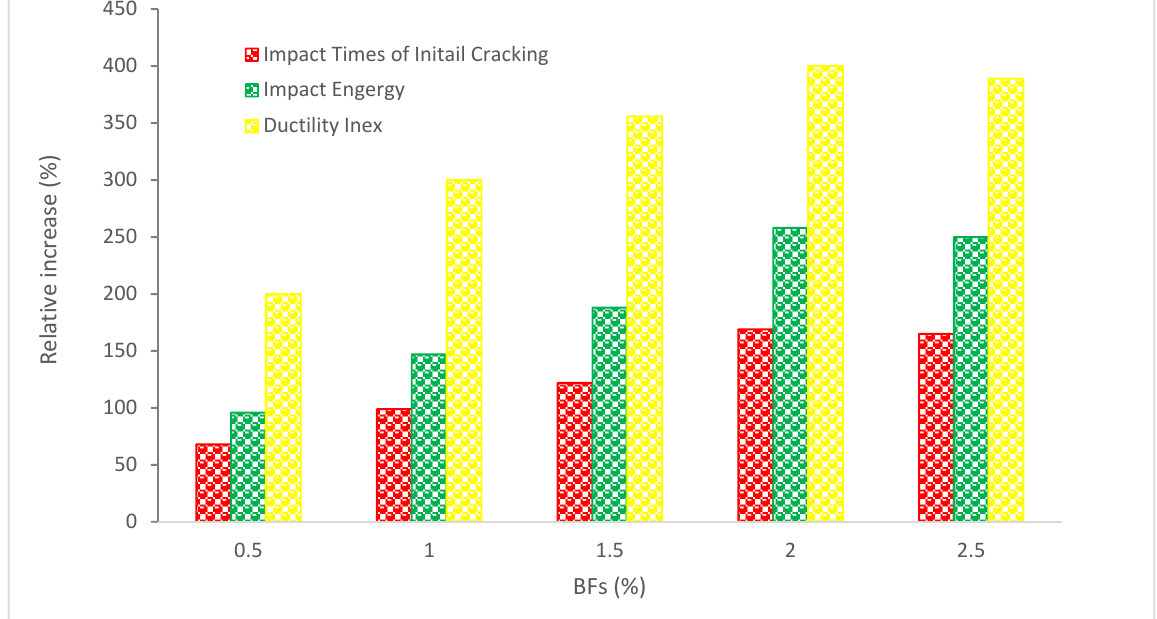
Figure 16. Impact Resistance Behaviors: Data Source [88].